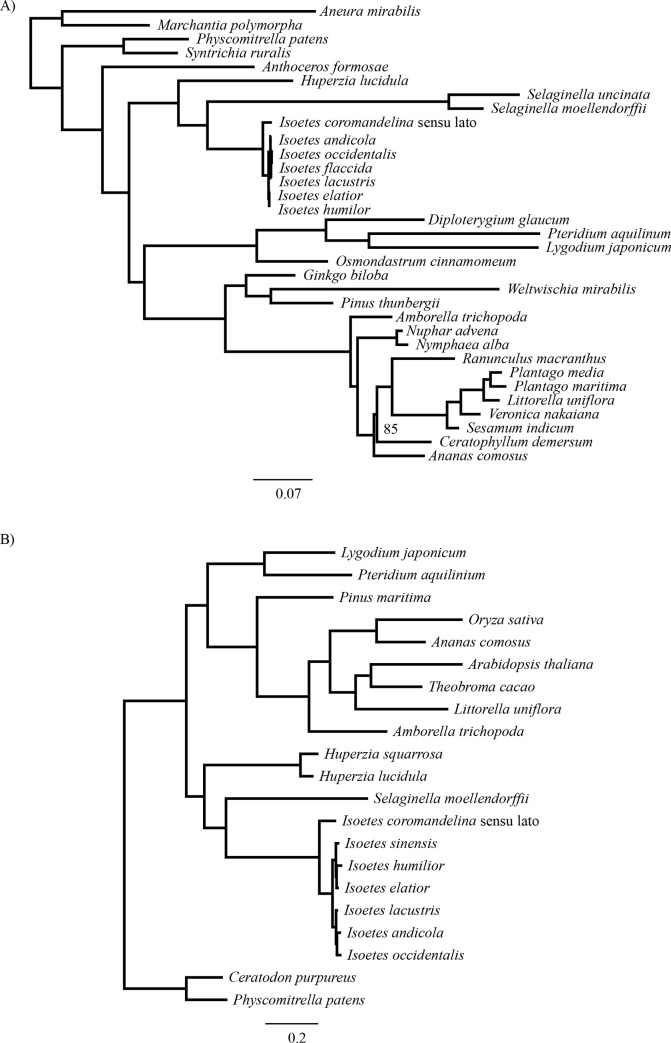
Maximum likelihood phylograms of concatenated chloroplast and nuclear markers.Phylograms are shown for a) concatenated chloroplast markers and b) concatenated nuclear markers. Branch lengths are proportional to the number of expected substitutions per site, with scale bar representing a) 0.07 and b) 0.2 substitutions per site. All bootstraps support values are 100 with the exception of the branch separating Ananas comosus from the clade containing Ceratophylum demersum in b), which has a support value of 85.